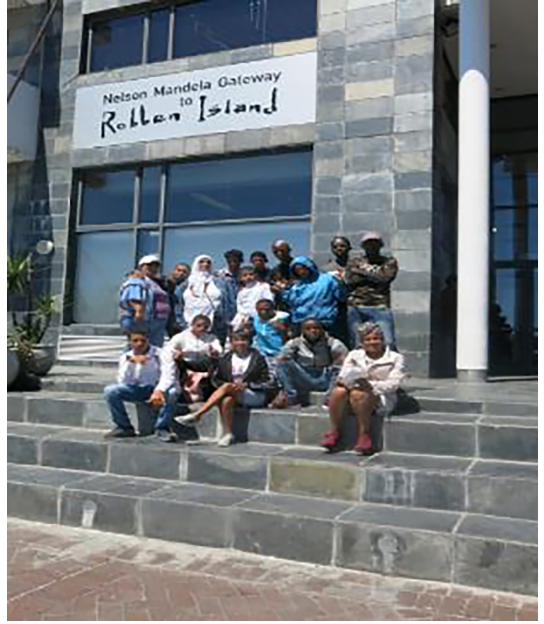
Image 5. Excursion to Robben Island Image: Youth participant, Victoria and Alfred Waterfront, Cape Town, 13